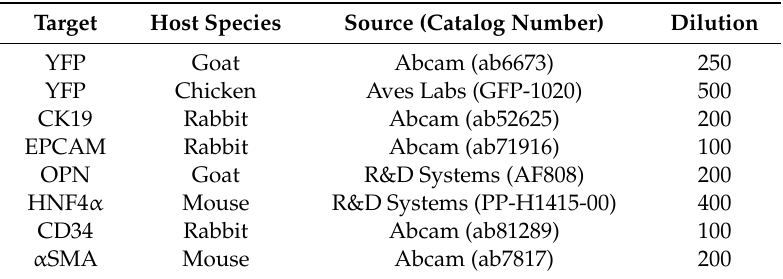
Table 1. Antibodies used for